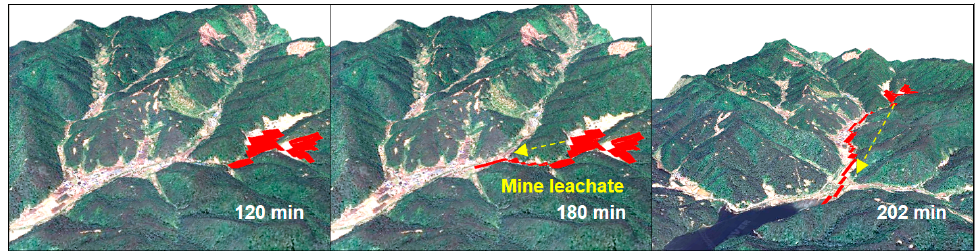
Figure 5. DEM grid-based hydrological mine leachate transport modeling with time: 120, 180, and 202 min